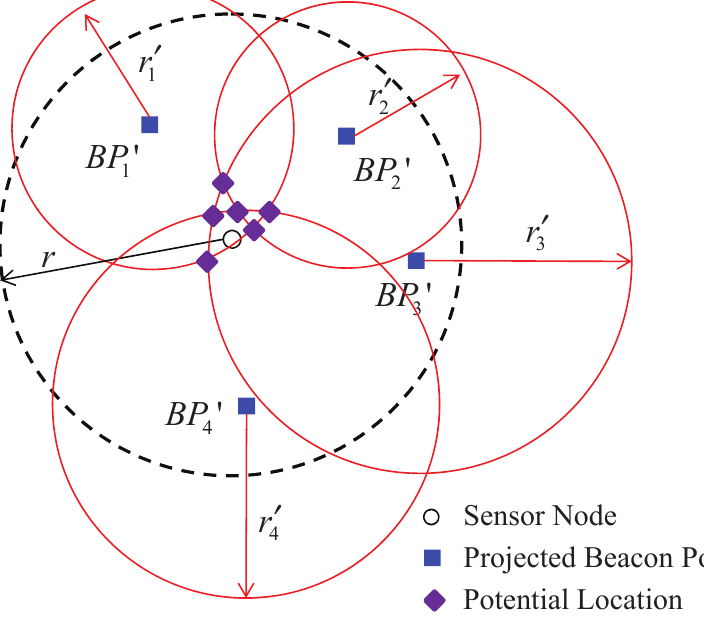
Figure 5. Estimation of the sensor node location using projected beacon points.